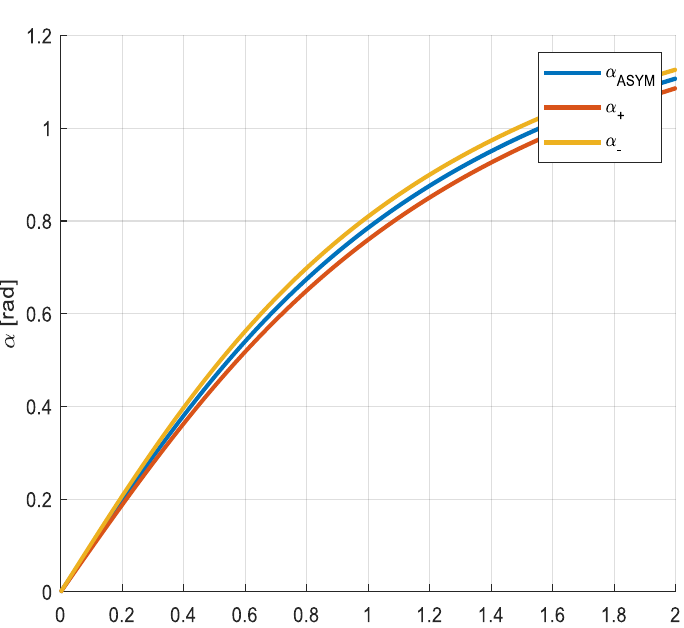
Figure 4. ACPST angle α range for 95% Un (yellow), Un (blue), and 105% Un (red).